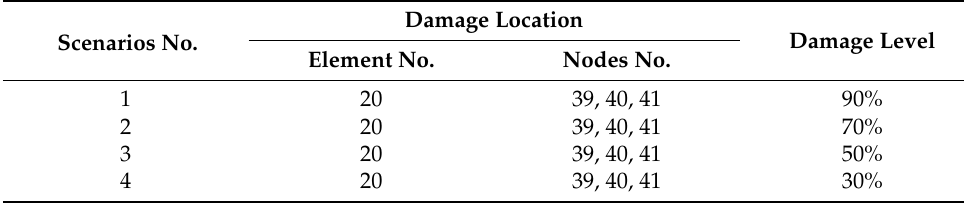
Table 2. Four damage scenarios for structural health monitoring. Scenarios